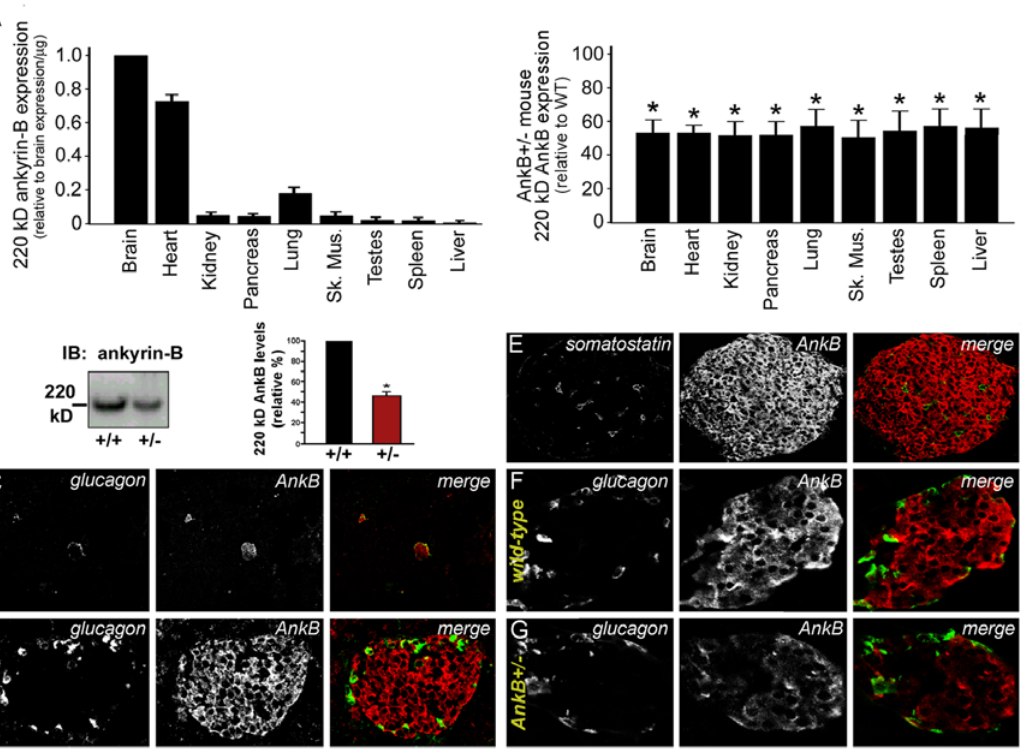
Figure 5. Ankyrin-B-haploinsufficiency in multiple cell types. A , Relative 220 kD ankyrin-B expression across mouse tissues. Right panel illustrates expression of 220 kD ankyrin-B in ankyrin-B + / 2 mouse tissues compared with wild-type littermate tissue (n . 3, p , 0.05). B , Quantitative immunoblot of 220 kD ankyrin-B expression in wild-type and ankyrin-B + / 2 mouse pancreas using ankyrin-B Ig. Protein levels were quantified by 125-labeled Protein A (n . 3). C–D , Immunolocalization of glucagon (left) and ankyrin-B (right) in the Islet of wild-type mouse pancreas. Note that we observe no immunoreactivity of ankyrin-B in the exocrine pancreas. E , Immunolocalization of somatostatin and ankyrin-B in wild-type islets. We observe no co- expression of ankyrin-B and somatostatin in delta cells. F , Immunolocalization of glucagon and ankyrin-B in wild-type mouse islets. We observe no co- localization of glucagon and ankyrin-B in alpha cells. G , Immunolocalization of glucagon and ankyrin-B in Islets of ankyrin-B + / 2 mice. Note the significant decrease in ankyrin-B levels.